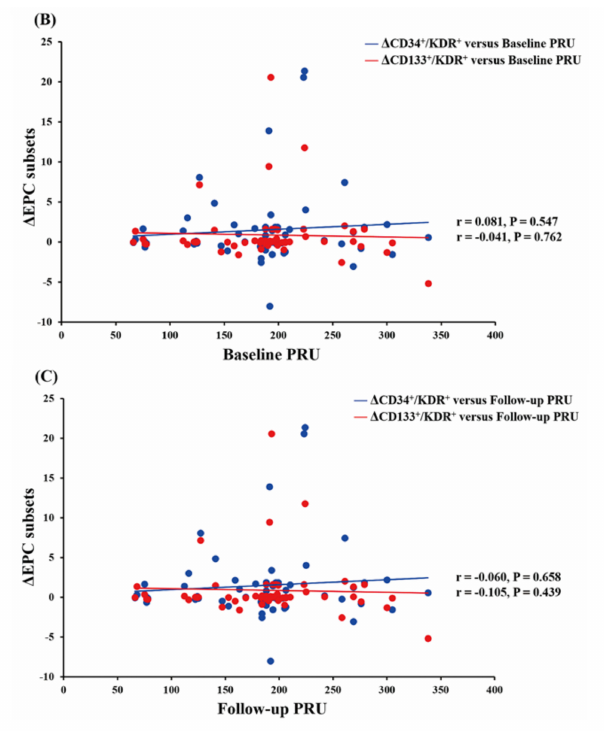
Figure 6. Correlation between EPC counts and platelet reactivity. Change of EPC levels did not show no significant correlation with change of platelet reactivity ( A ), and change of EPC levels were not related with the levels of platelet reactivity ( B and C